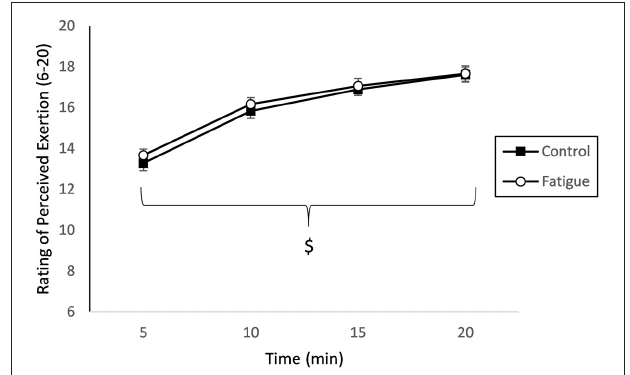
FIGURE 5 | Perceived Exertion. RPE as a function of time-on-task raw scores. $ indicated main effect of time ( p < 0.001). Data are presented as mean ±